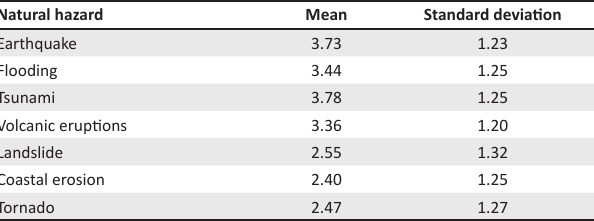
TABLE 4: Descriptive summary results of the influence of trusted information on hazard risk